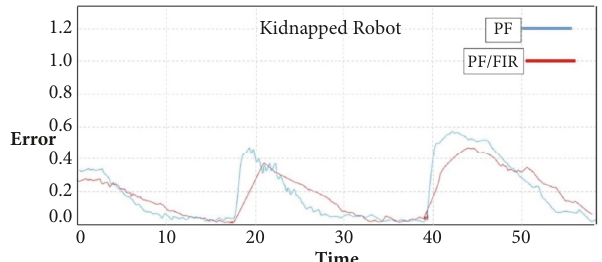
Figure 10: Position errors in the kidnapped robot